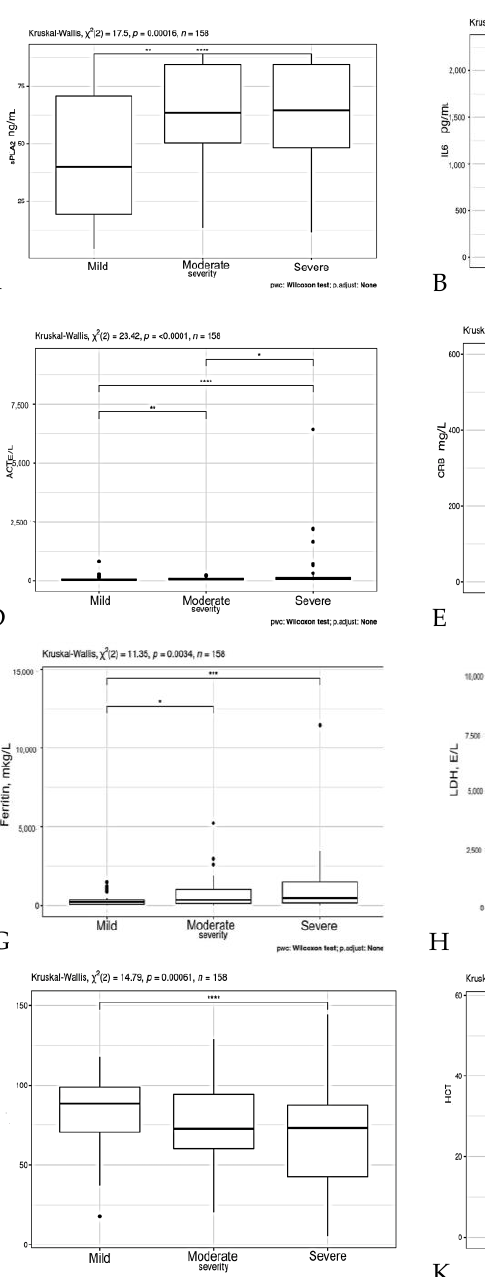
N Figure 1. PLA2 ( A ), IL-6 ( B ), APTT ( C ), ACT ( D ), CRB ( E ), D-dimer ( F ), ferritin ( G ), LDH ( H ), pro- calcitonin ( I ), and GFR ( J ) levels, and hematocrit ( K ), lymphocytes ( L ), neutrophils ( M ), leucocytes ( N ), eosinophils ( O ) in patients depending on the severity of the COVID-19 infection. The results are presented as the arithmetic means ± standard deviation. The significance levels evaluated as * p < 0.05; ** p < 0.01; *** p < 0.001; and **** p < 0.0001. The results shown in Figure 1 show that the levels of APTV, AST, CRP, LTK, IL-6, D- dimer, and ferritin, as well as the number of neutrophils, significantly increased in pa- tients with mild and severe COVID-19 infections (Figure 1). On the contrary, hematocrit, GFR, lymphocyte, and eosinophil levels were statistically significantly reduced in these groups of patients compared to the values in patients with a mild infection. The PLA2 level also significantly increased in mild to moderate COVID-19 infections, but it did not change in patients with severe infections. These data on changes in the level of PLA2 in the blood show that this enzyme can be considered as an early marker of exacerbation of COVID-19 infection. IL-6 and PLA2 levels were also analyzed depending on the severity of the disease according to computed tomography (Figure 2).